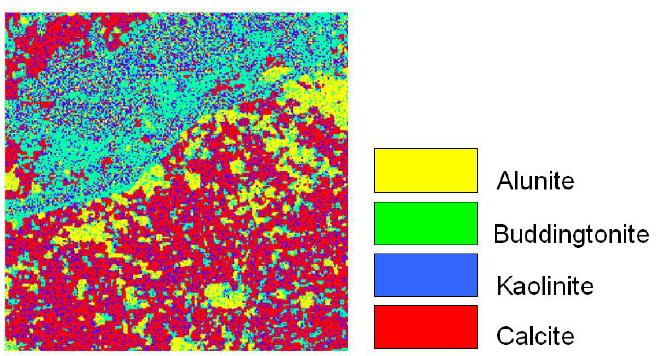
Figure 5. Mineral classified map.